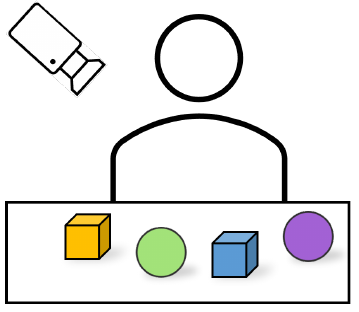
Figure 10. Sequential touching experiment.